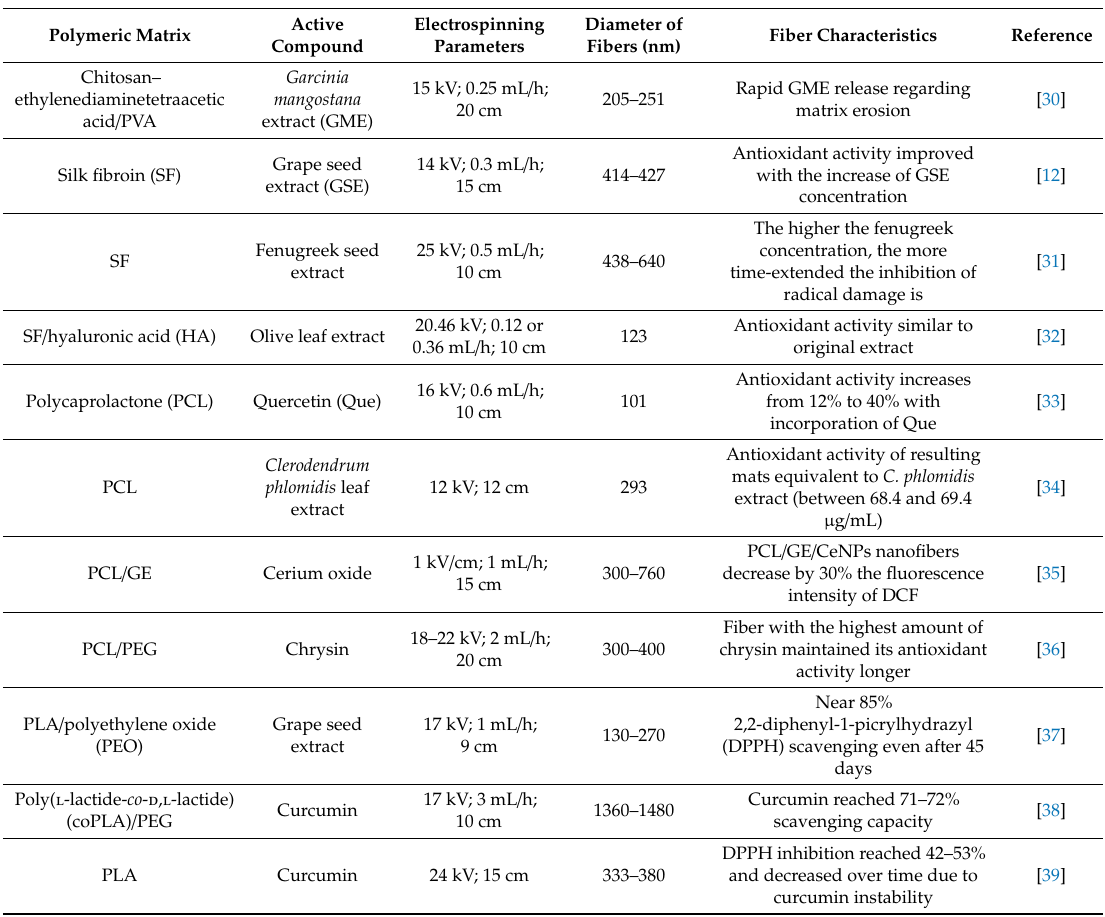
Table 2. Composition and characteristics of antioxidant nanofibers proposed for wound dressings from 16 reviewed